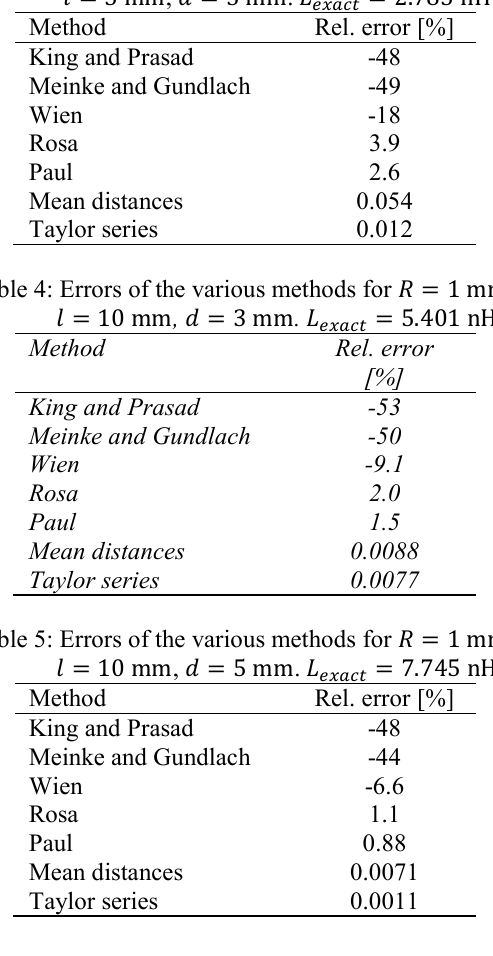
Table 3: Errors of the various methods for